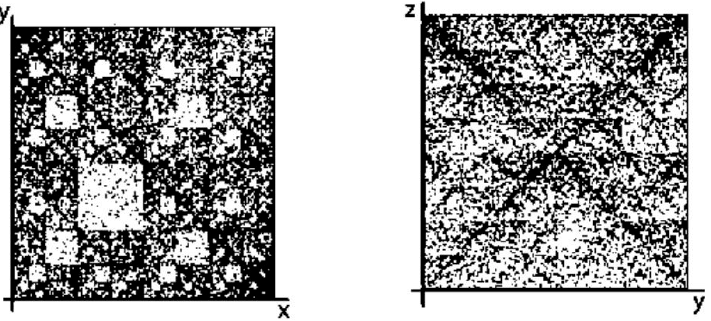
Figure 4. Two examples of patterns which are constructed on the base of the described method. Left side: the visual pattern of the nucleotide sequence Homo sapiens chromosome 22 genomic scaffold, which has 648,059 nucleotides and which is divided into a sequence of 16-mers; these 16-mers are transformed into 16-bit binary numbers on the basis of the first sub-alphabet and of the second sub-alphabet (Figure 2); then their decimal equivalents are plotted on the x and y axes respectively. Right side: the visual pattern of the nucleotide sequence Arabidopsis thaliana mitochondrion, which has 366,924 nucleotides and which is divided into a sequence of 16-mers; these 16-mers are transformed into 16-bit binary numbers on the basis of the second sub-alphabet and of the third sub-alphabet (Figure 2); then their decimal equivalents are plotted on the axes “ y ” and “ z ” respectively.